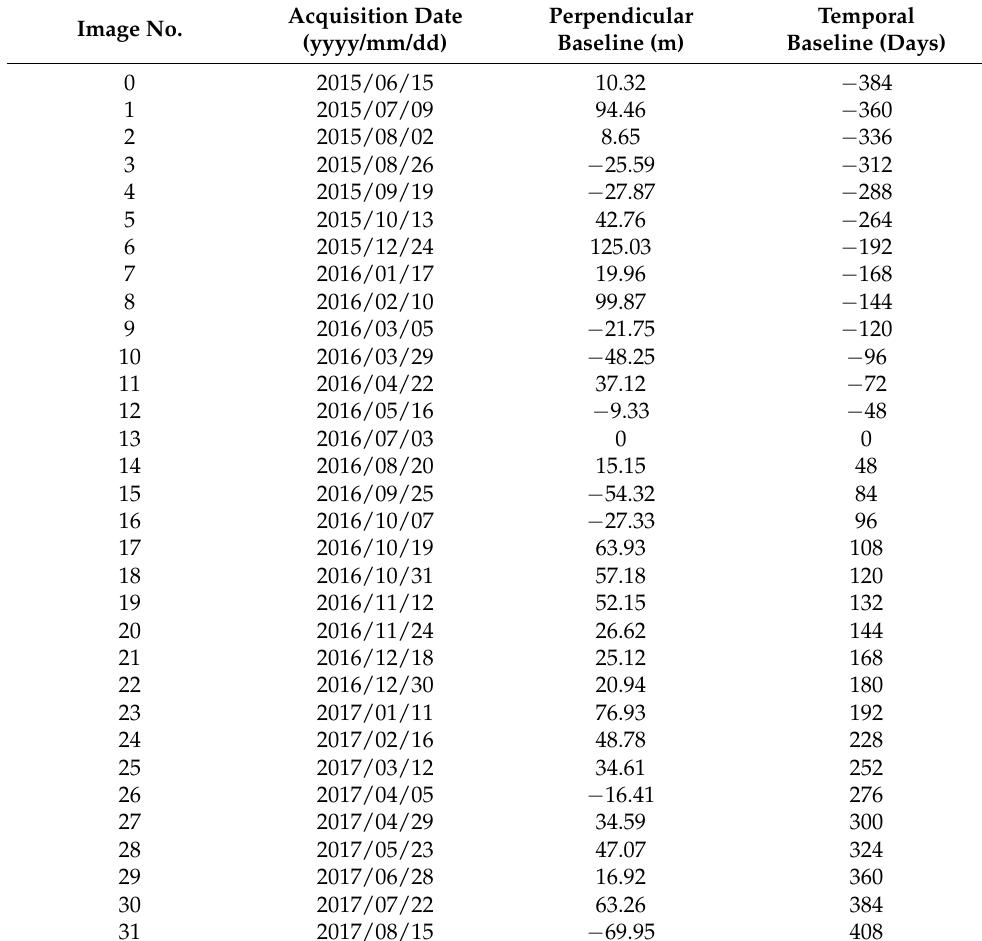
Table 4. Interferometric pairs and sensor parameters (Ascending, Orbit No. 11). Image